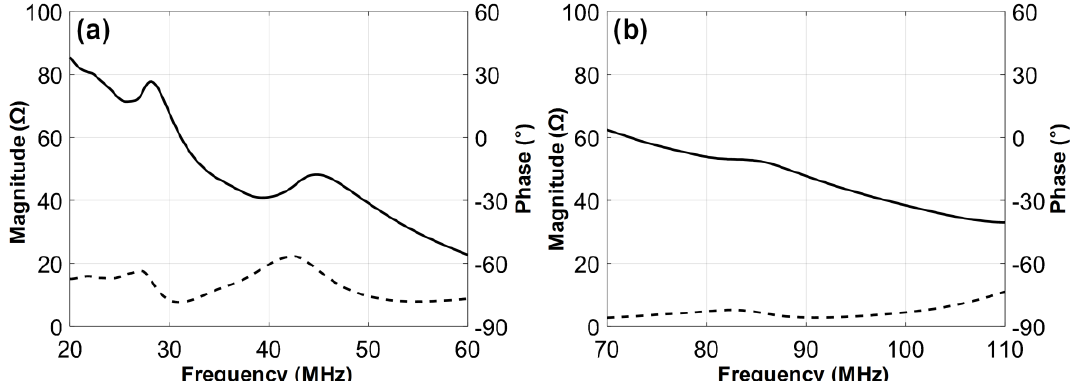
Figure 7. Measured electrical impedance magnitudes (solid line) and phase angles (dashed line):